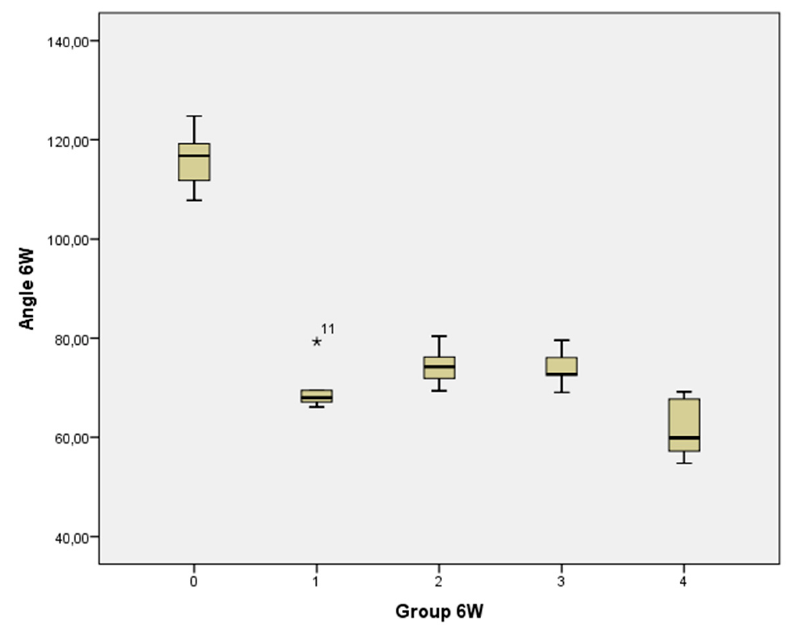
Figure 6. Box plot of angles obtained with a 6 W lamp at different irradiation times, including the control. The graphs show the lower (Q1), mean (Q2), and upper (Q3) quartiles. The whiskers represent the highest and lowest values. All groups presented statisti- cally significant differences with respect to the control. The 120 min group also showed statistically significant differences from the 30 and 60 min groups.